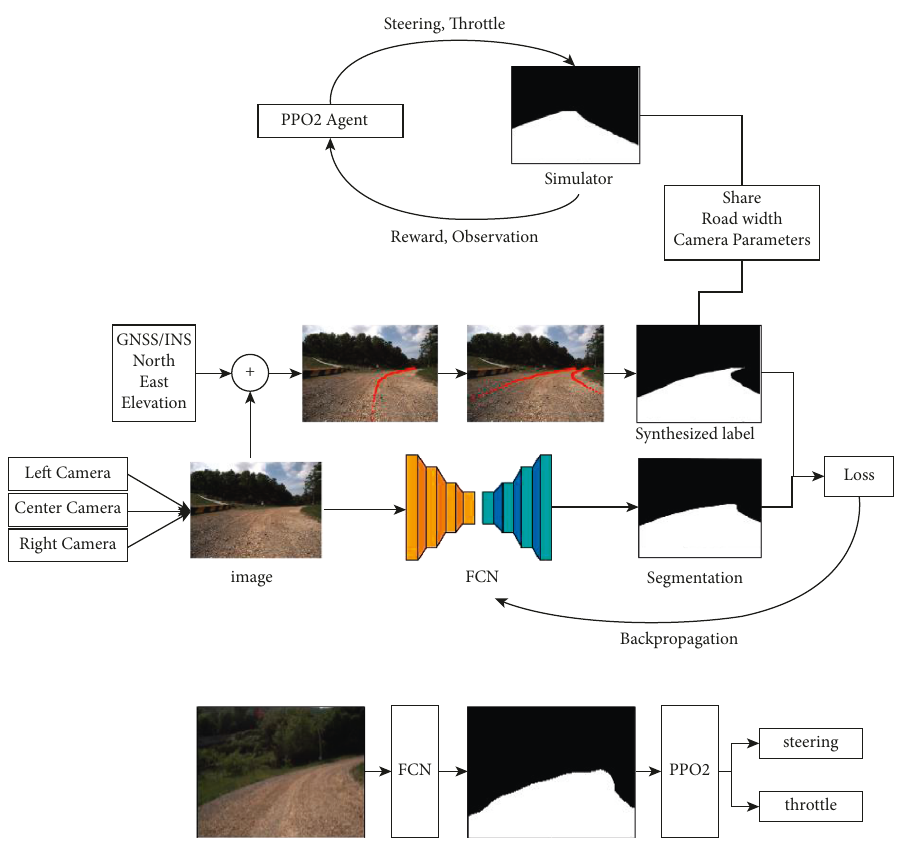
Figure 1: Overall architecture of our